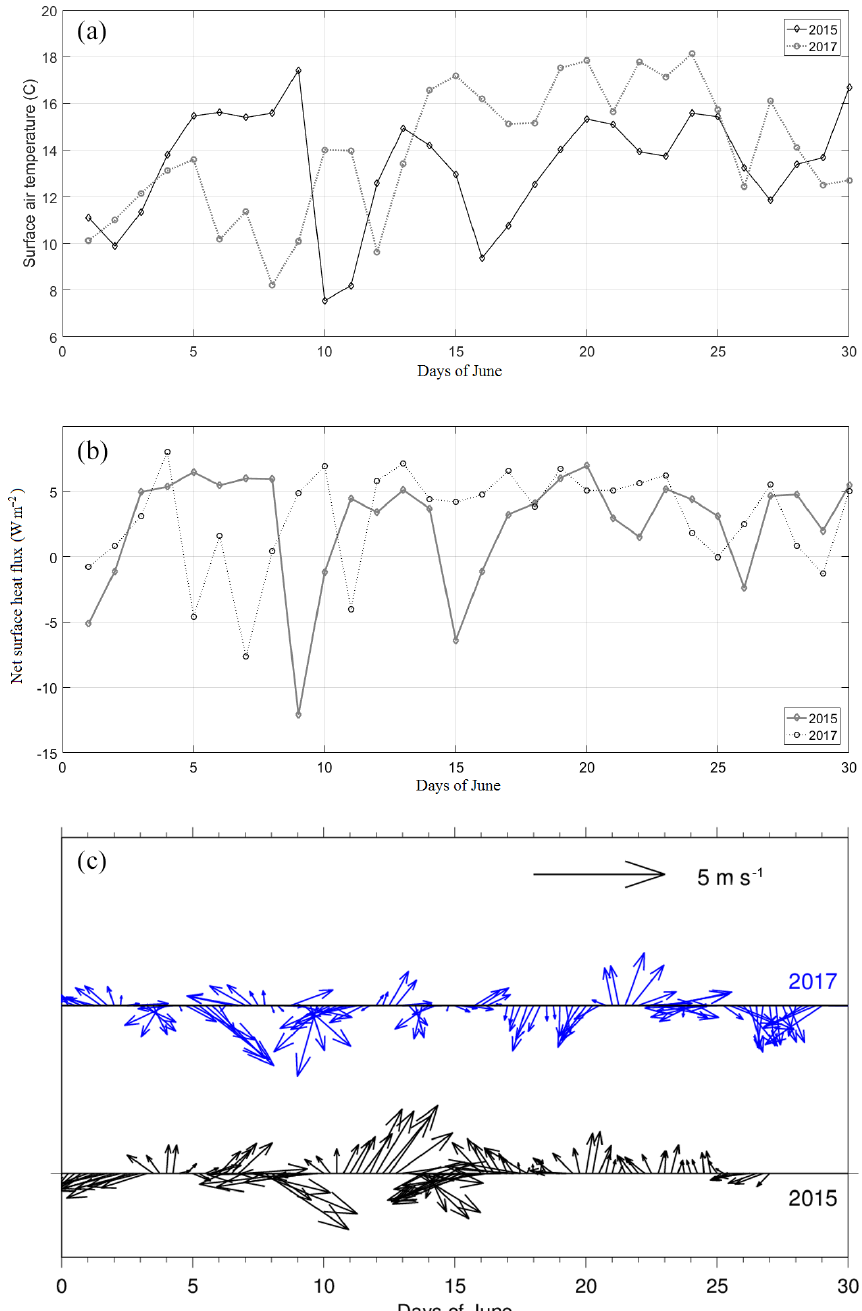
Figure 8. (a) Air temperature at 2m height in June 2015 and June 2017 from ERA-Interim reanalysis. (b) Net surface heat flux in June 2015 and June 2017. Positive sign corresponds to gain of heat by the lake. (c) Wind speed vectors at 2m height in June 2015 (black) and June 2017 (blue) from ERA-Interim reanalysis. The data correspond to the point 42 ◦ 20 (cid:48) N, 77 ◦ 30 (cid:48) E in the central part of the